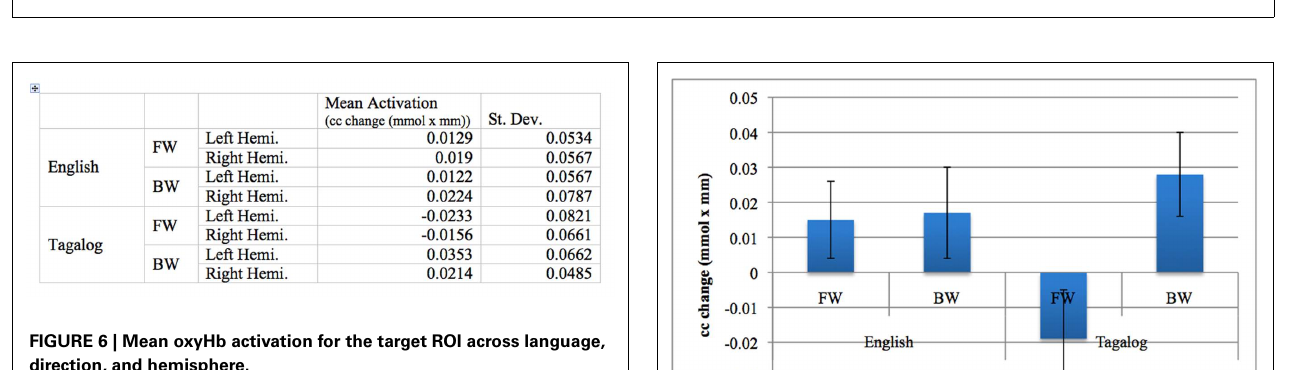
FIGURE 5 |Averaged oxy- and deoxyHb response for each condition, across hemisphere and channel.